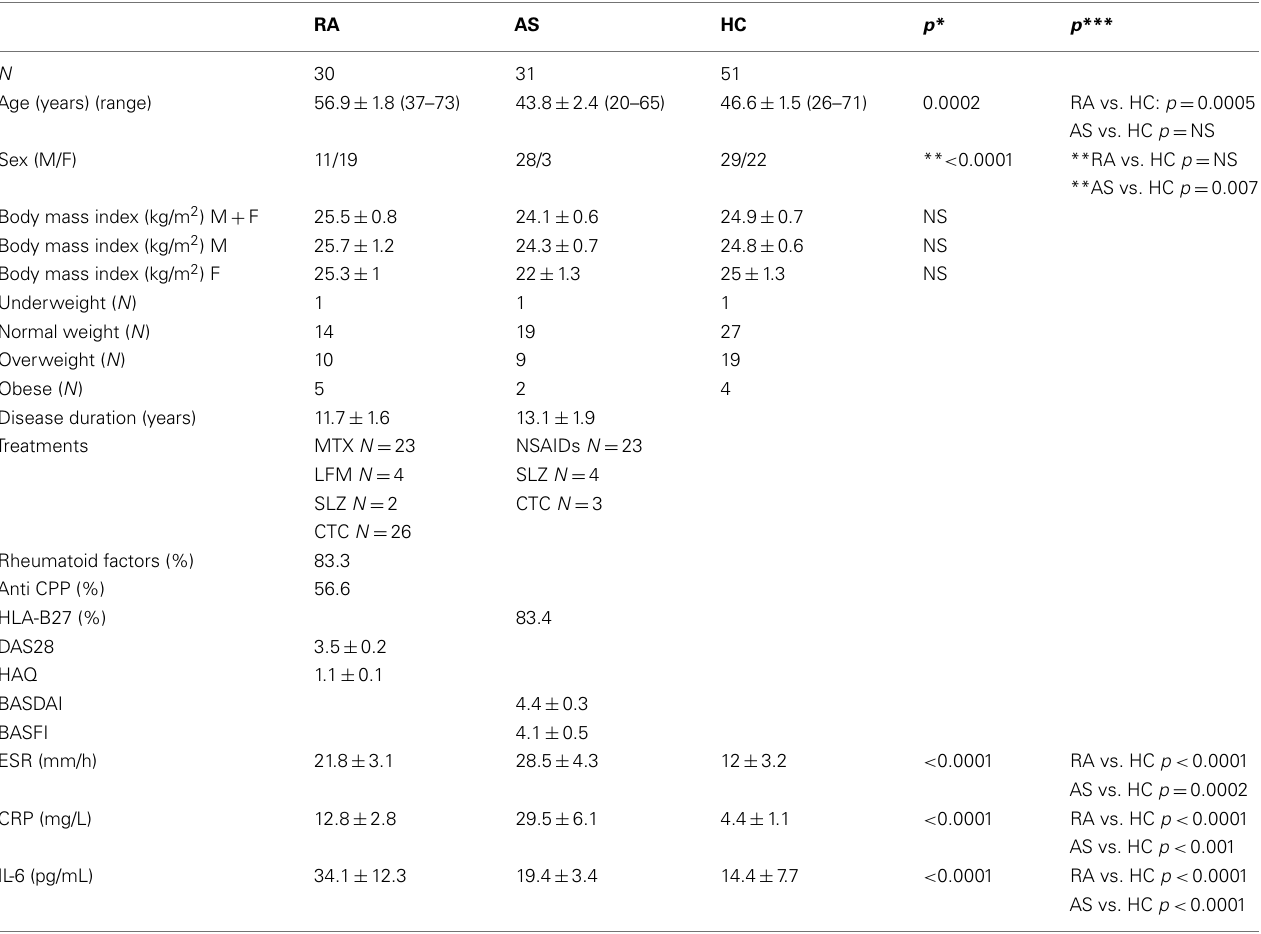
Table 1 | Clinical and demographic characteristics of patients with rheumatoid arthritis (RA), ankylosing spondylitis (AS), and healthy controls (HC)